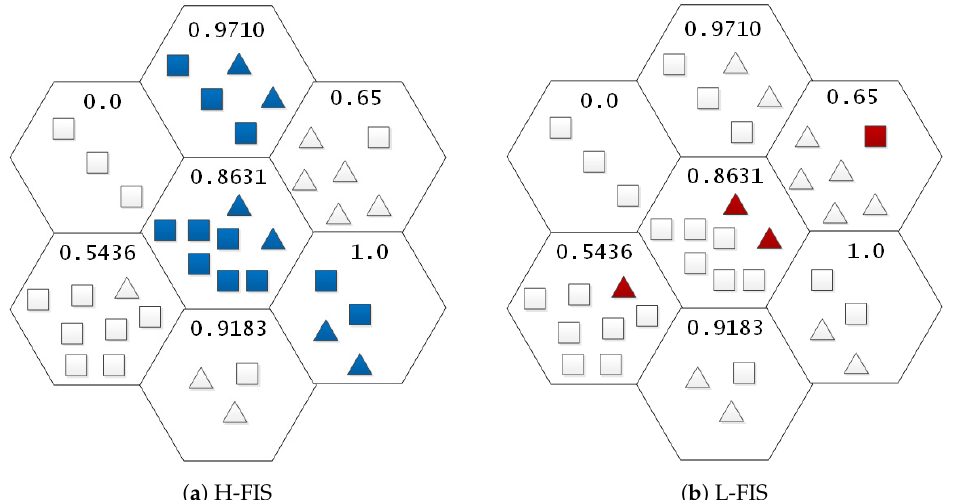
Figure 1. Example of the selection process to decide which instances should be removed in a hypothetical dataset after the use of SOM using H-FIS ( a ) and L-FIS ( b ). The value of the threshold hyperparameter was set at 0.8631 for both H-FIS and L-FIS. The instances selected for removal in this scenario are